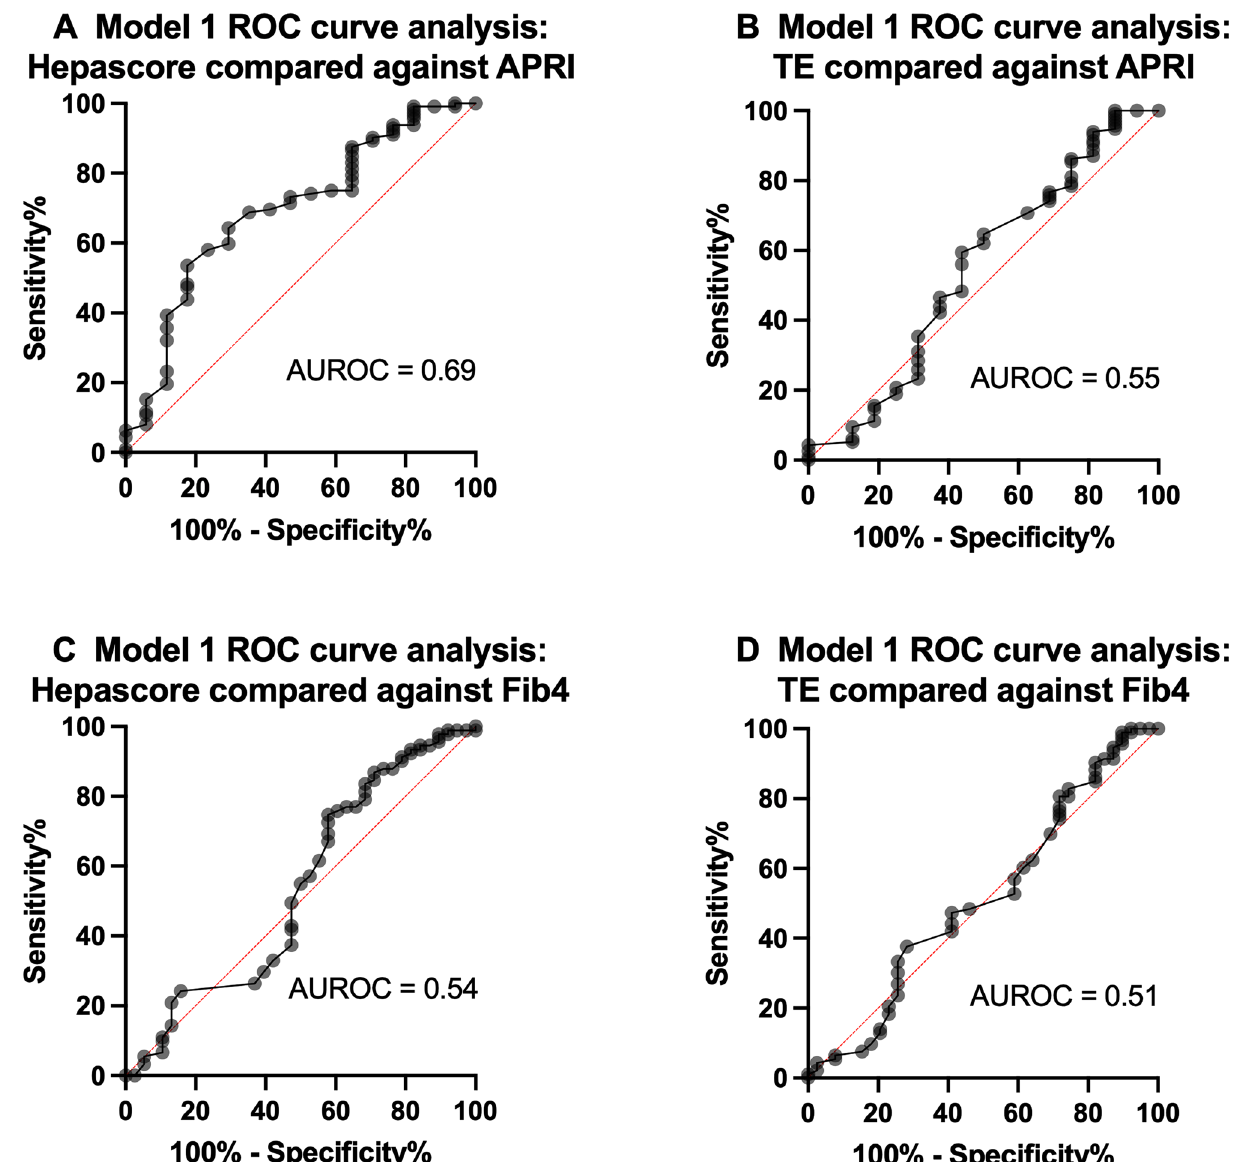
Figure 2. Receiver-operator characteristic curve analysis for Model 1 comparing Hepascore against APRI > 0.44 ( A ), TE against APRI > 0.44 ( B ), Hepascore against Fib4 > 1.1 ( C ), or TE against Fib4 > 1.1 ( D